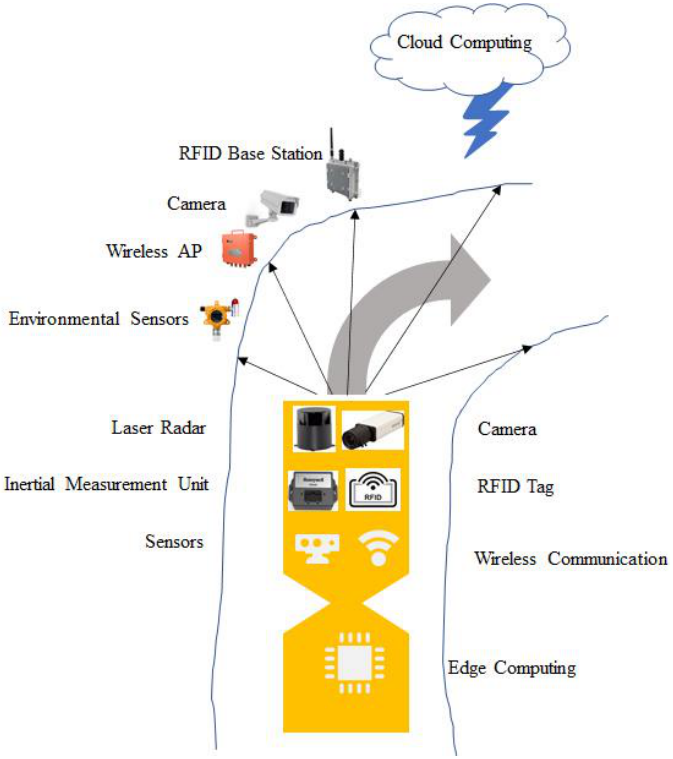
Figure 2. The main sensors and operating modes of autonomous driving vehicles.